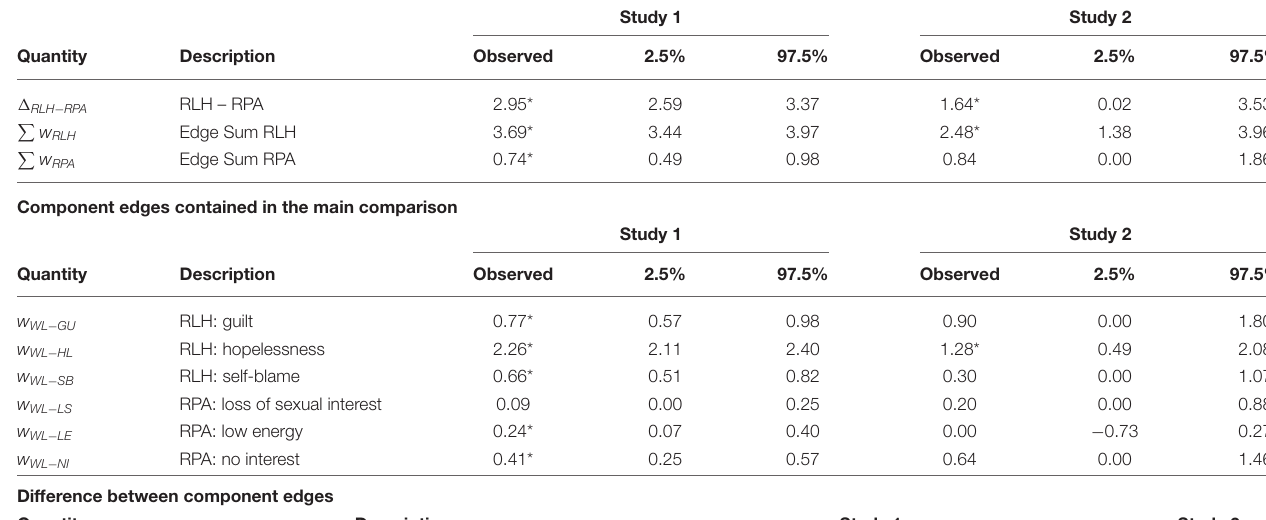
TABLE 1 | Bootstrap tests for associations of worthlessness. Primary test of